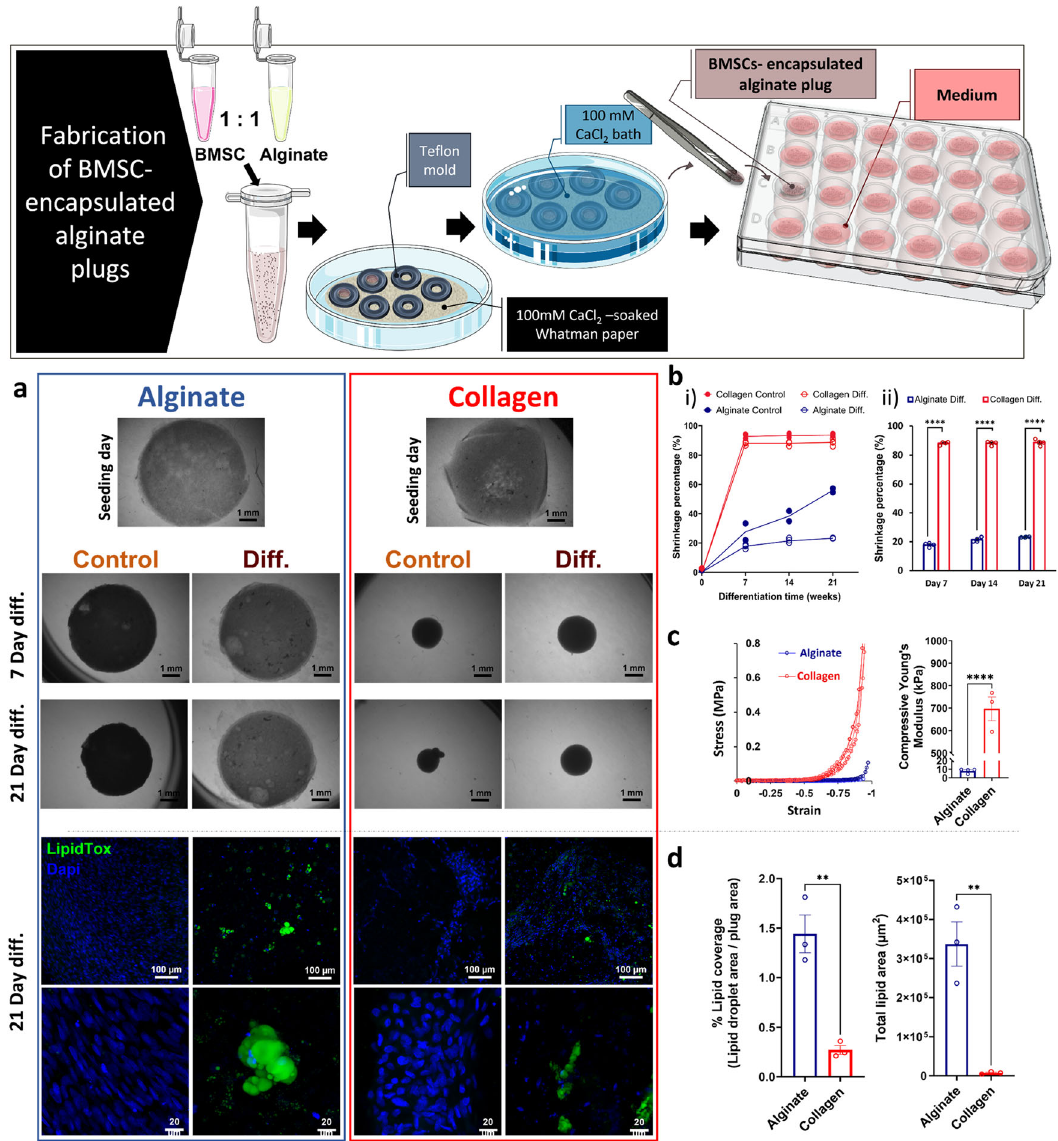
Fig. 2 In fl uence of matrix material on engineered adipose tissue formation. Top panel: Illustration of BMSC-loaded alginate plug fabrication. Image credits: this fi gure was created using elements from Servier Medical Art (https://smart.servier.com). a (top panel) Bright- fi eld images of BMSC-loaded alginate and BMSC-loaded collagen constructs cultured in differentiation medium (diff.) or standard medium (control), as captured on seeding day, and after 7, 14, and 21 days of differentiation, scale bar 1 mm. b Shrinkage percentage of the constructs (relative to their original size) (i) All samples: differentiation or control in alginate or in collagen over 21 days of differentiation, (ii) BMSC-loaded alginate vs. BMSC-loaded collagen constructs after 7, 14, and 21 days in differentiation medium n = 4. c Compressive stress – strain curves and calculated Young ’ s modulus of BMSC-loaded alginate vs. BMSC- loaded collagen constructs after 21 days in differentiation medium, n = 3, Student ’ s t -test, error bars show SE, **** p < 0.0001. a (bottom panel) Confocal laser scanning microscopy images (green, LipidTox; blue, DAPI) of BMSC-loaded alginate and BMSC-loaded collagen constructs cultured in differentiation medium or in standard medium, for 21 days, scale bars: 100 µ m (top) and 20 µ m (bottom). d Quanti fi ed lipid droplet coverage and total lipid area of LipidTox-stained differentiated alginate vs. collagen constructs, n = 3, Student ’ s t -test, error bars show SE, ** p <